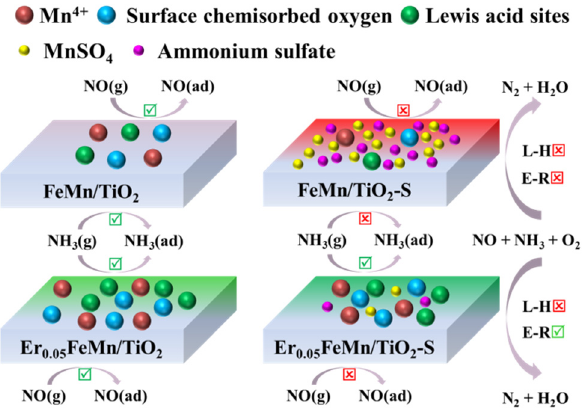
Figure 10. The promotional effect and mechanism of Er modification on SO 2 resistance for NH 3 -SCR at low temperature over FeMn/TiO 2 catalysts.